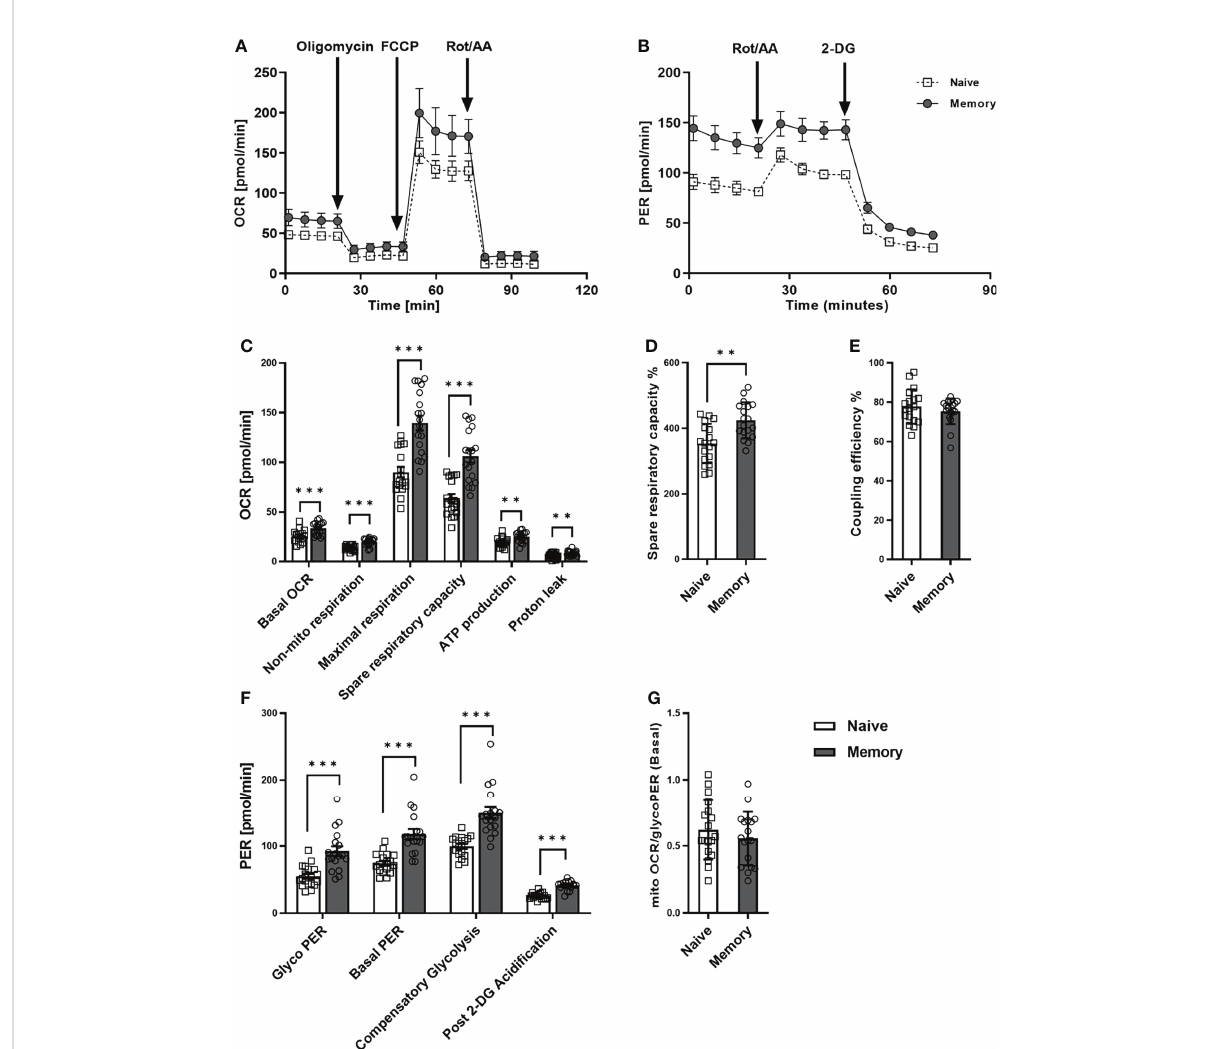
FIGURE 1 Mitochondrial pro fi le and glycolytic function of naive and memory CD4 + T cells. Naive and memory CD4 + T cells were analyzed with regard to OCR or PER under basal conditions and after addition of the indicated reagents. Representative example of the Seahorse XF Cell Mito Stress Test kinetic pro fi le and Glycolytic Rate kinetic pro fi le of naive and memory CD4 + T cells (A, B) . Comparison of basal OCR, non-mito respiration, maximal respiration, spare respiratory capacity, ATP production, proton leak, spare respiratory capacity%, coupling ef fi ciency between naive and memory CD4 + T cells (C – E) . Comparison of basal glycolysis, basal PER, compensatory glycolysis, post 2-DG acidi fi cation rate (F) and basal mitoOCR/glycoPER ratio (G) between naive and memory CD4 + T cells (mean ± SD; n = 18). A paired t test or Wilcoxon signed-rank test was performed after the normality test. **P<0.01; ***P<0.001. OCR, oxygen consumption rate; PER, proton ef fl ux